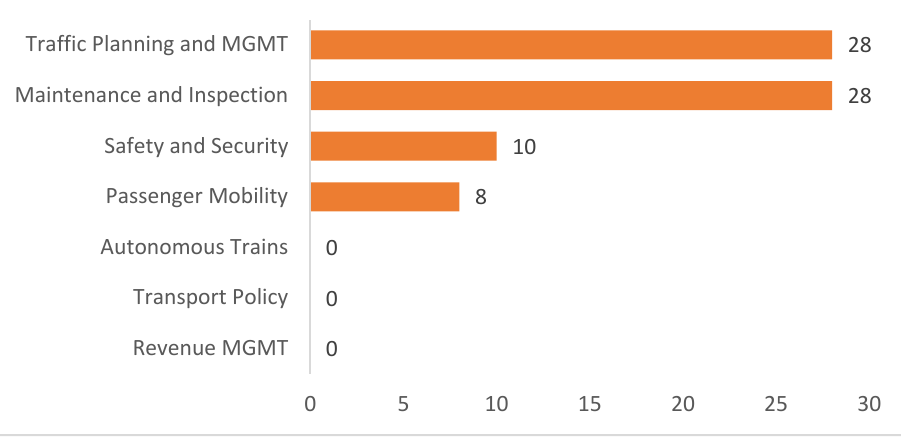
Figure 1. Number of datasets (y-axis) divided by railway application (x-axis).